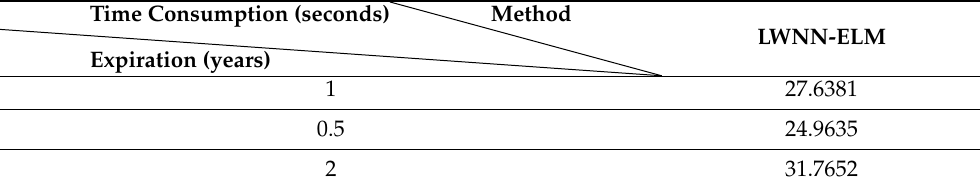
Figure 3. Options price for different α , where the corresponding parameters are σ = 0.45, r = 0.03, q = 0.01, K = 10, A = 3, B = 15, and M = 16. ( a ) T = 1 (years); ( b ) T = 0.5; ( c ) T = 2. Table 2. Time consumption of the LWNN-ELM for different